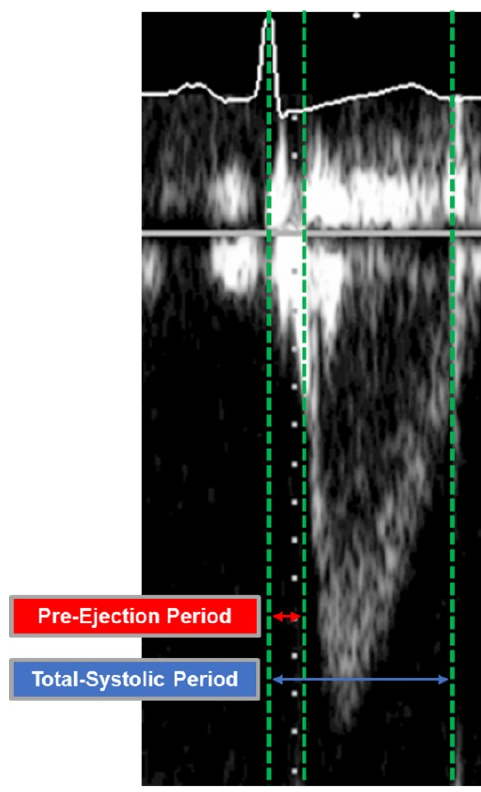
Figure 2. Assessment of the Pre-Ejection and the Total-Systolic Period of the Left Ventricular Outflow Tract. A pulsed wave Doppler was positioned over the aortic valve in apical five-chamber view.